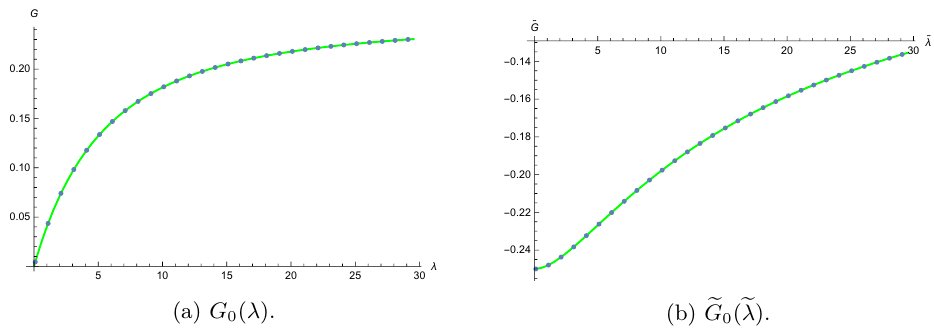
Figure 4. Plot of a G 0 ( λ ) and b e G 0 ( e λ ) . The solid green curves represent the left hand side of (B.2) for N = 20 , while the blue dots represent the genus-zero result in